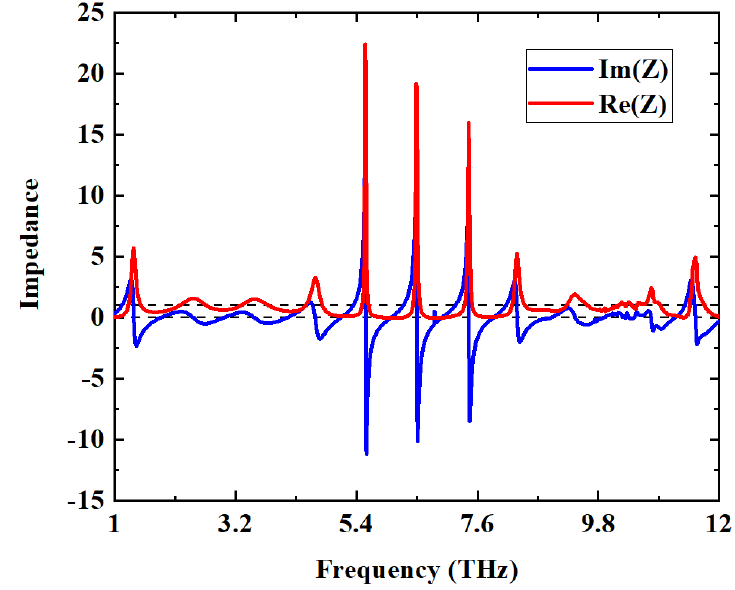
Figure 4. The relative impedance with the conductivities of VO 2 is 2 × 10 5 S/m.